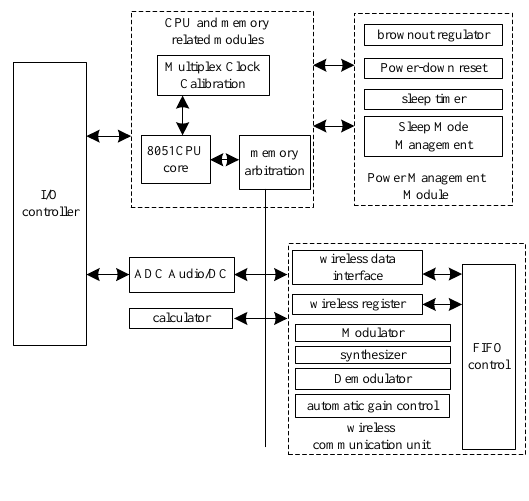
Figure 2. Structure diagram of wireless communication